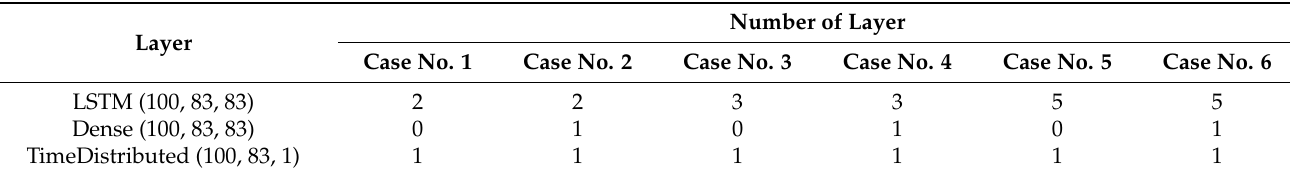
Table 1. Selected architectures of the analysed recurrent neural networks. Number of Layer Layer Case No. 1 Case No. 2 Case No. 3 Case No. 4 Case No.